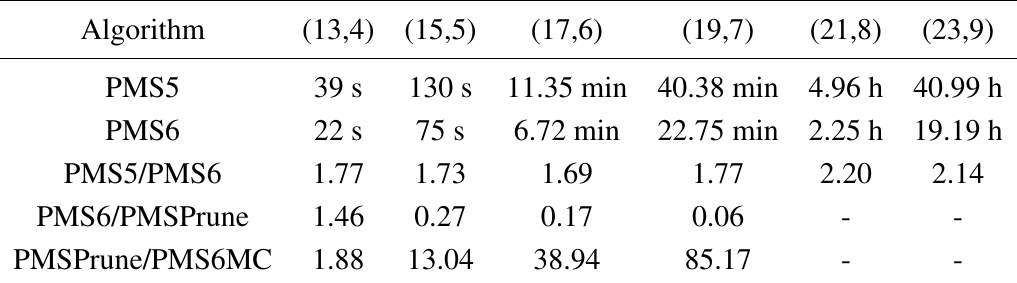
Table 4. Total run time of different PMS